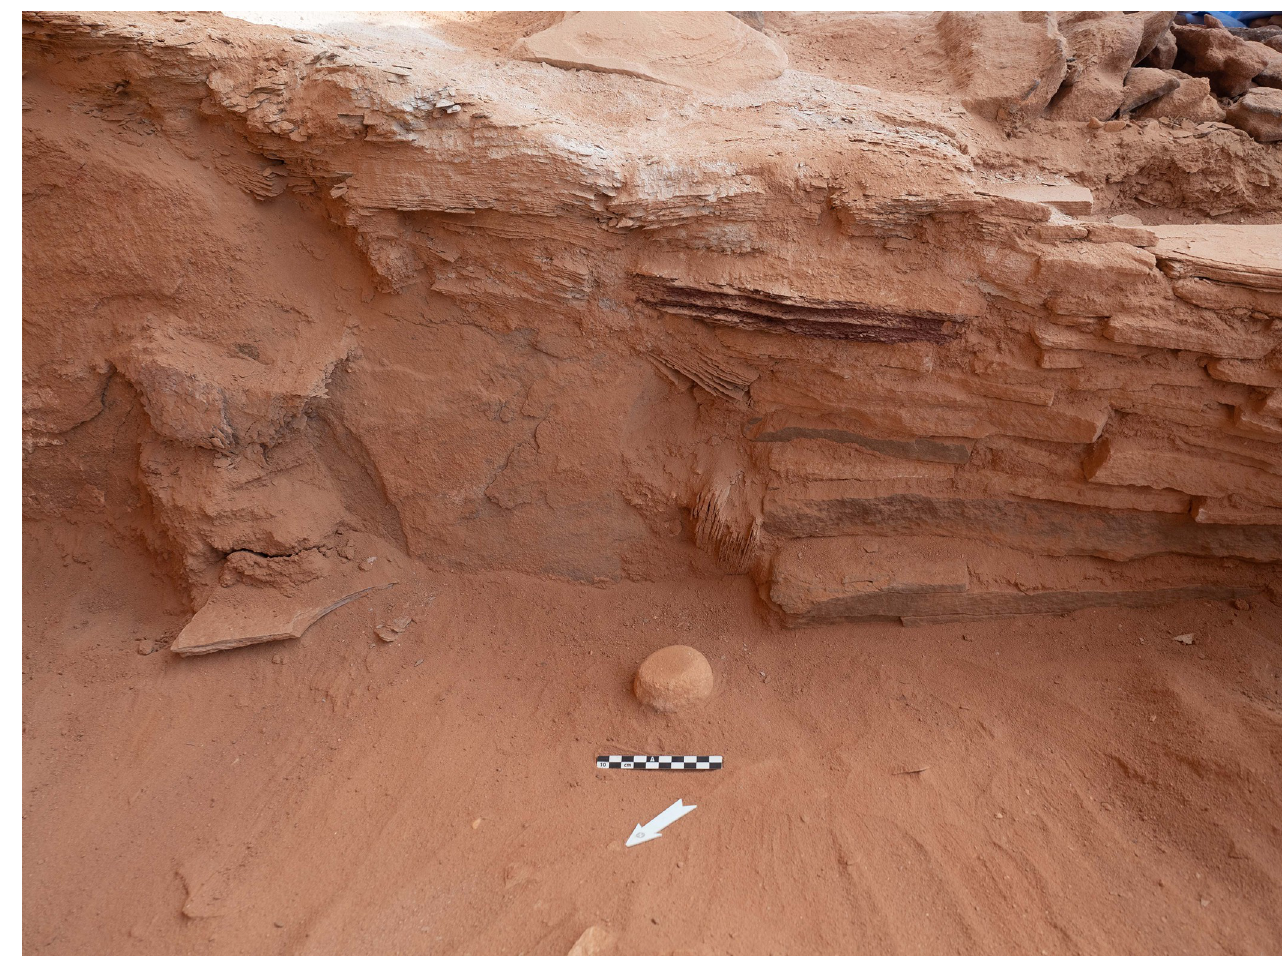
Fig 9. Transverse grooved hammer stone found upside down and in situ in Phase